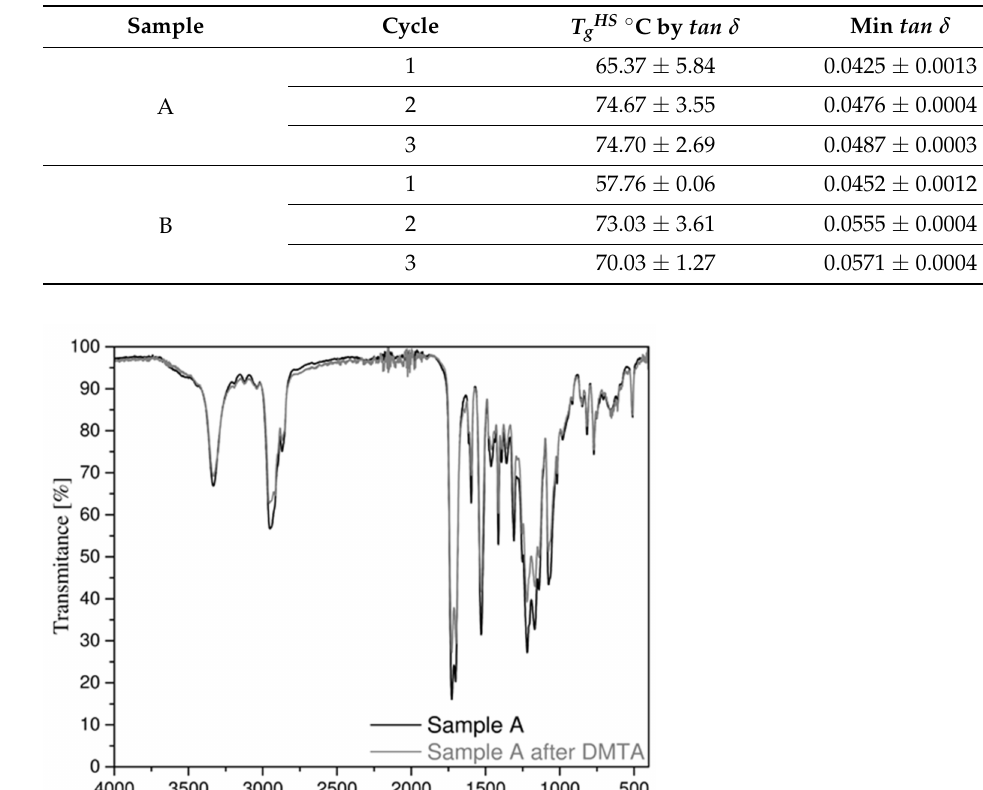
Table 4. T gHS values determined in DMTA test.